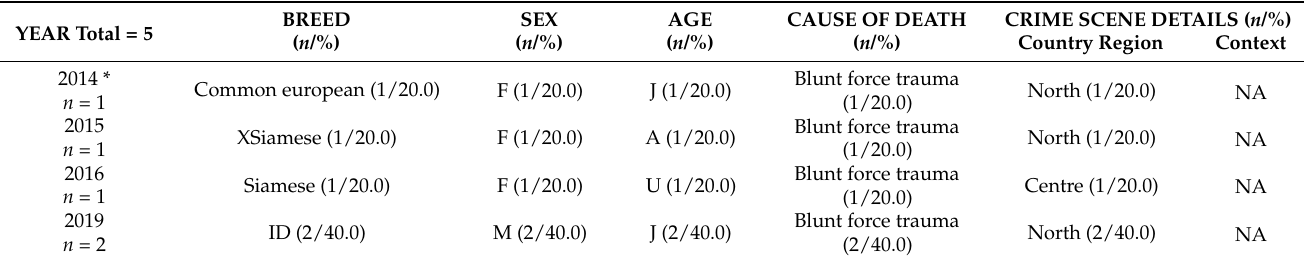
Table 2. Characterization of the feline cases of violent death confirmed through forensic necropsy.